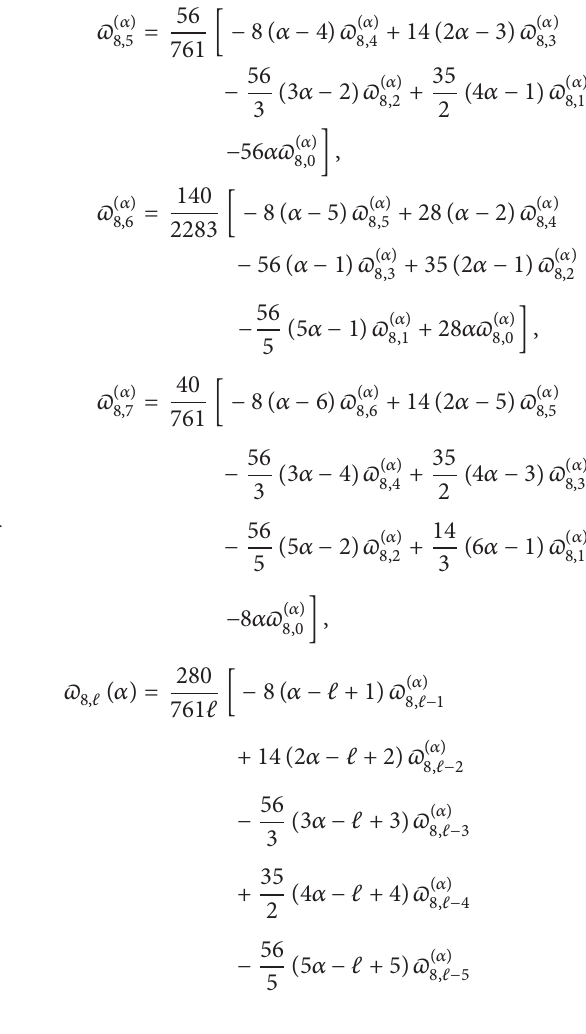
140 𝜛 (𝛼) = [−8 (𝛼 − 1) 𝜛 (𝛼) 8,2 761 280 = 𝜛 (𝛼) [−8 (𝛼 − 2) 𝜛 (𝛼) 8,3 2283